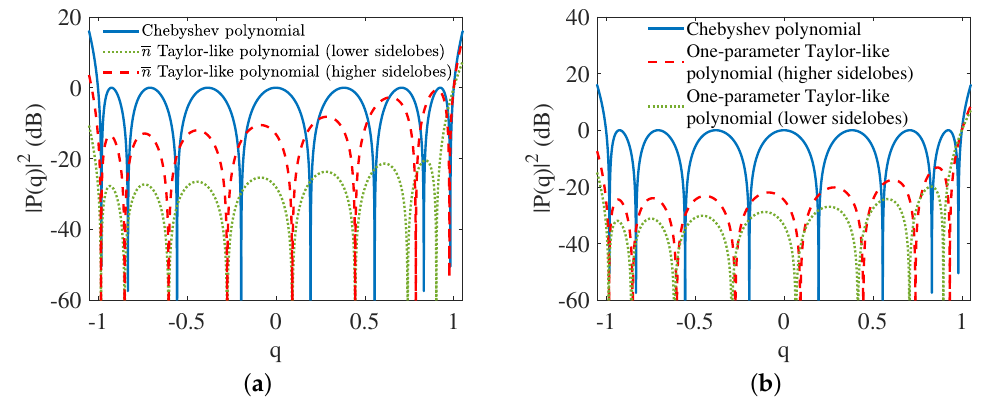
( q − Re [ z n ]) where Re denotes the real part. ( a ) Comparison of Figure 1. Polynomials P ( q ) = ∏ N − 1 n = 1 Chebyshev (blue line) and n Taylor-like polynomials where the red dashed line denotes a 0dB preset first sidelobe level and green dotted line denotes a − 20 dB preset first sidelobe level. ( b ) Comparison of Chebyshev (blue line) and one-parameter Taylor-like polynomials where the red dashed line denotes when B = 0 and the green dotted line denotes a − 20 dB preset first sidelobe level.